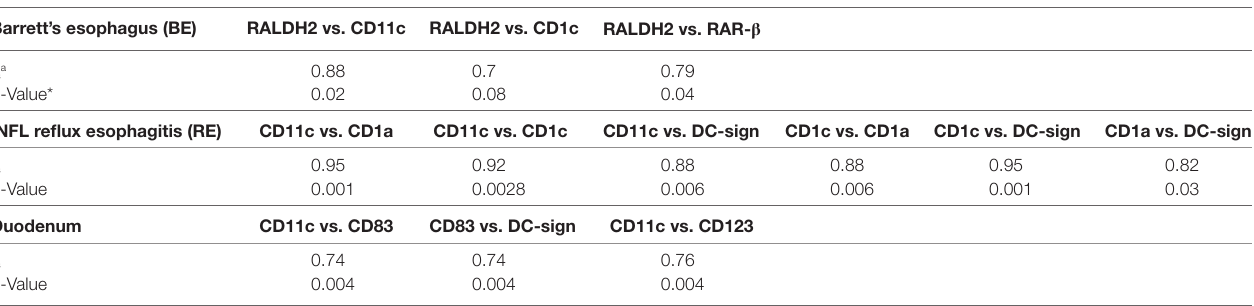
Upper section: correlations between RALDH2 with CD11c, CD1c, and RAR- β in BE tissue; middle section: correlations of mRNA expression levels in INFL RE; lower section: correlations in duodenal tissue. Correlations were adjusted for multiple testing by Benjamini–Yekutieli method. a Correlation coefficient. *Significant if p <